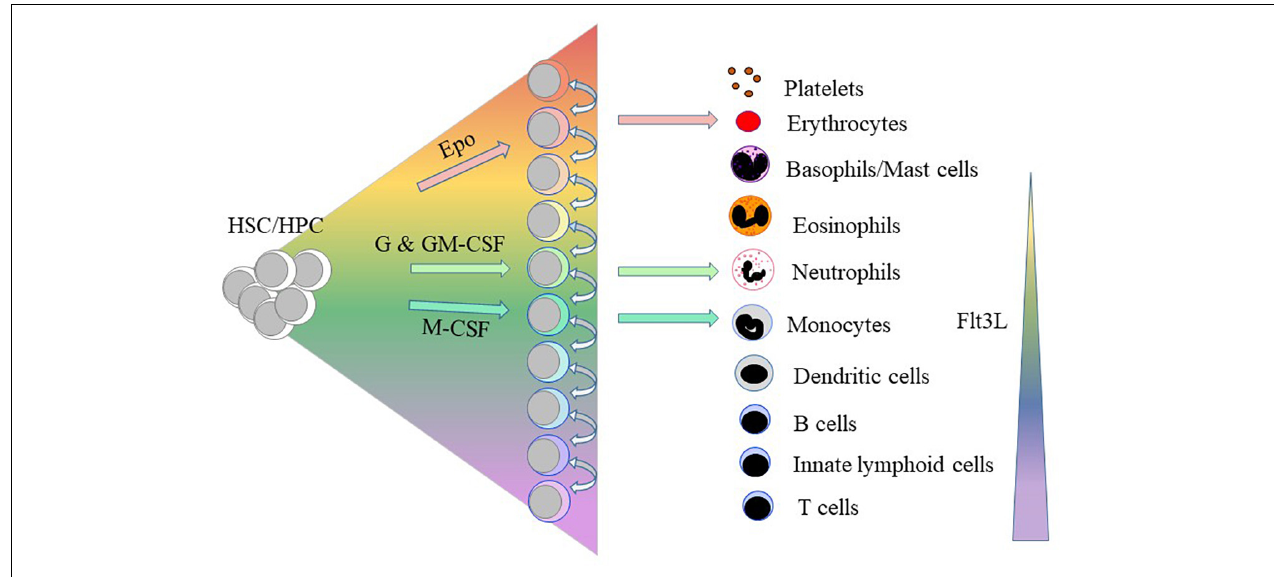
FIGURE 2 | Some of the haematopoietic cytokines instruct the lineage fate of haematopoietic stem and progenitor cells. Erythropoietin (Epo), granulocyte colony-stimulating factor (GSF)/granulocyte/macrophage colony-stimulating factor (GM-CSF) and macrophage colony-stimulating factor (M-CSF) instruct hematopoietic stem cells (HSCs)/hematopoietic progenitor cells (HPCs) to adopt erythroid, neutrophil and macrophage fates, respectively. Above a certain threshold level, the ligand for the fms-like tyrosine kinase 3 (Flt3L) drives HSC development along the myeloid-lymphoid pathways as opposed to the generation of megakaryocyte and erythroid